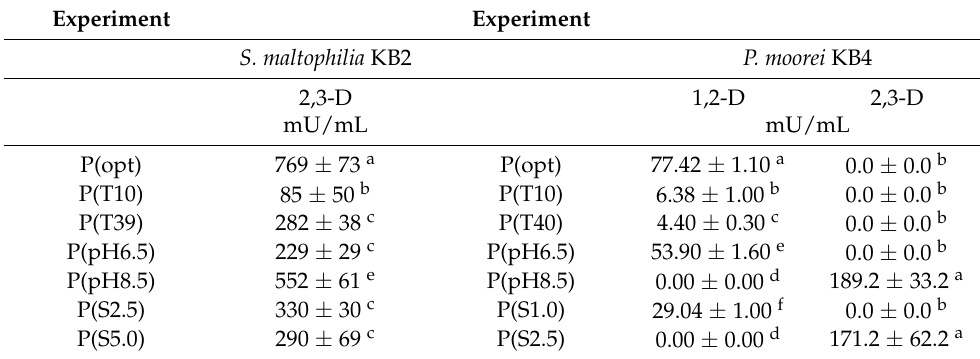
Table 2. The activity of catechol 2,3-D in S. maltophilia KB2, and catechol 1,2-D and catechol 2,3-D in P. moorei KB4 during degradation of phenol under different culture